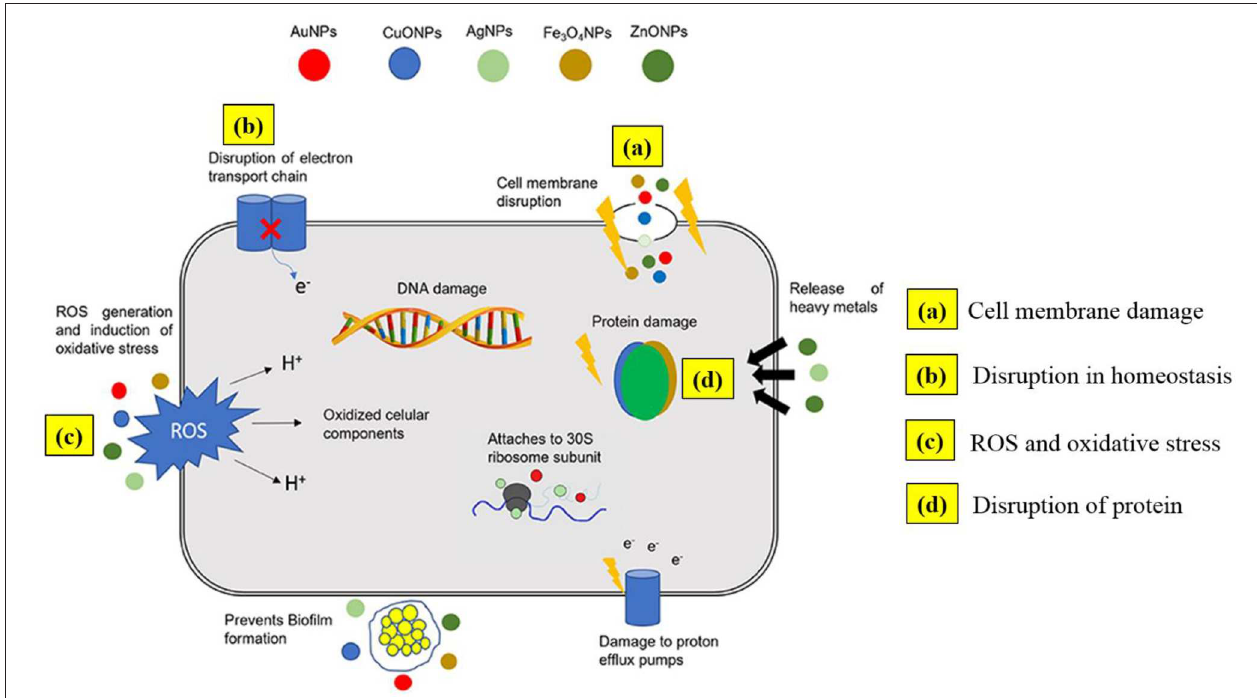
FIGURE 2 | Outline of possible antimicrobial mechanisms by metal nanoparticles. Adapted from Baptista et al. (2018) under the Creative Commons CC BY